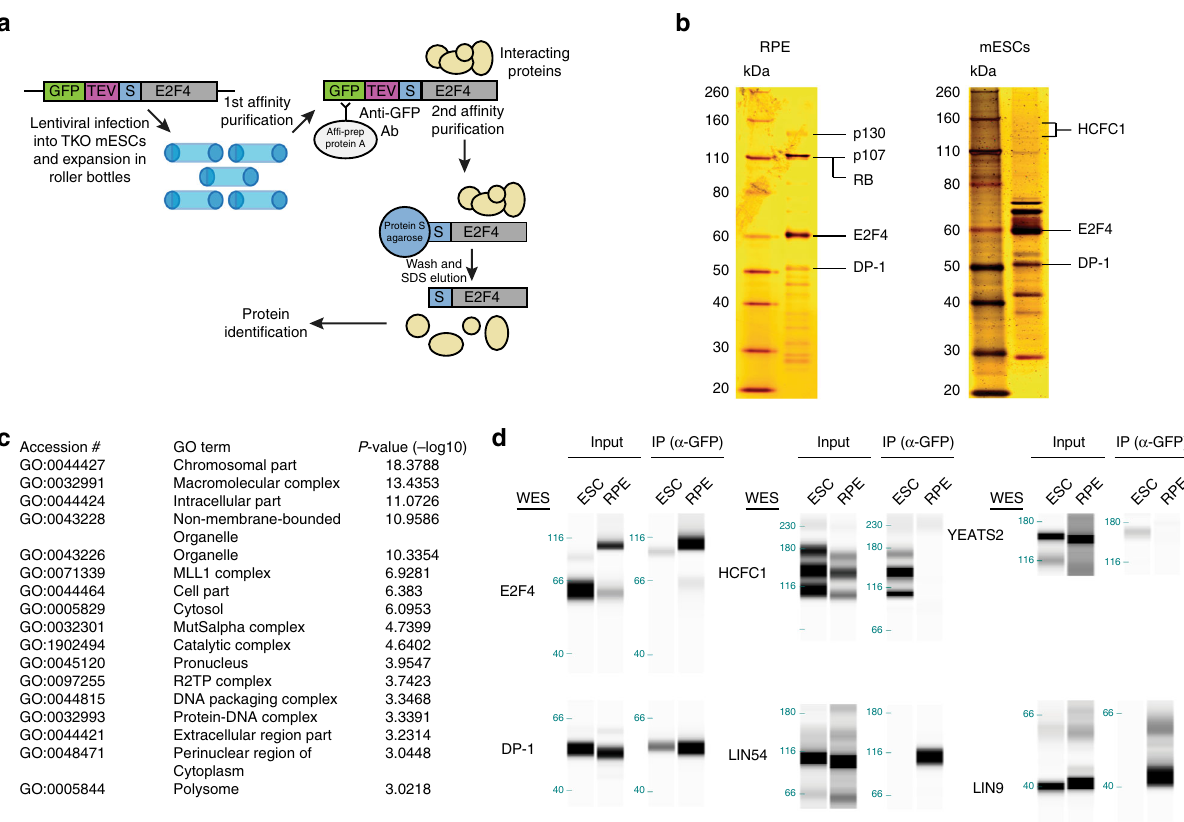
Fig. 7 Transcriptional activation by E2F4 in mouse ES cells is mediated by chromatin modi fi ers. a Schematic representation of the af fi nity puri fi cation-mass spectrometry approach to identify the E2F4 interactome. b Silver stain of eluted fractions from RPE cells and mouse ES cells . Slices of gel were subjected to mass spectrometry, and the indicated protein bands were identi fi ed by analyzing the proteins enriched in each slice. c GO terms for cellular components enriched in the list of mouse ES cell-speci fi c candidate interactors. d Validation of interactions between GFP-E2F4 and DP-1, HCFC1, YEATS2, LIN54, and LIN9, by co-immunoprecipitation followed by immunoassay, in mouse ES cells and human RPE cells. Transcriptional activators (HCFC1 and YEATS2) preferentially bind to E2F4 in mouse ES cells while members of the DREAM repressor complex (LIN54 and LIN9) bind preferentially to E2F4 in RPE cells. Molecular weights (kDa) are indicated on the left side (one experiment shown of at least two